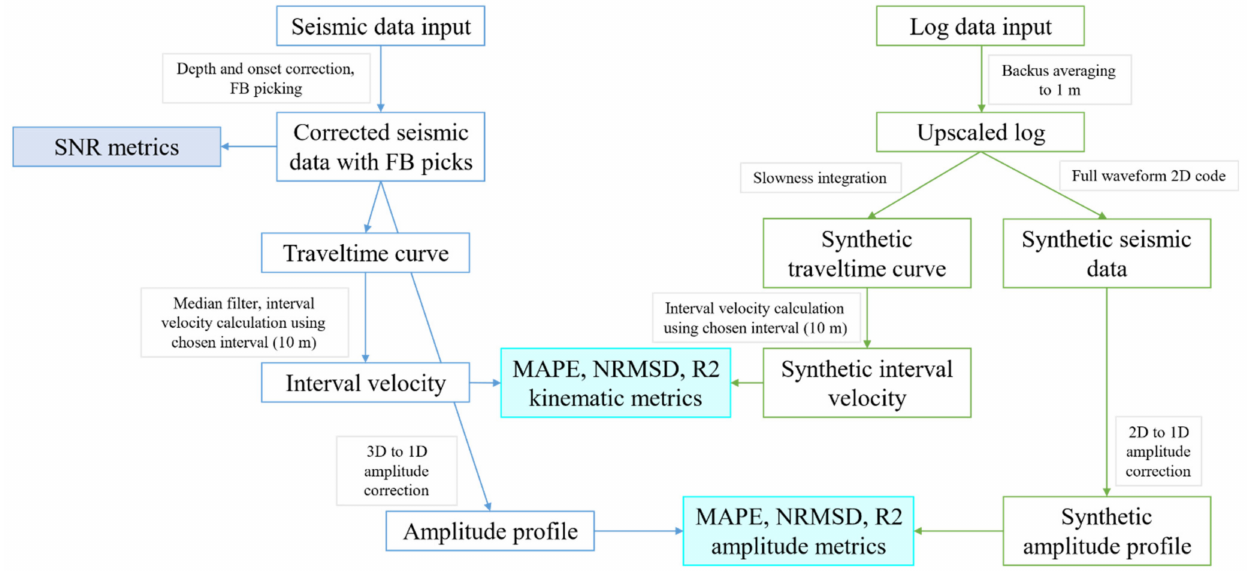
Figure 2. Data analysis workflow. DAS VSP seismic data and log data are inputs. The blue branch shows seismic data processing, while the green branch indicates operations with log data to generate “true” references for quantitative evaluation of DAS VSP data